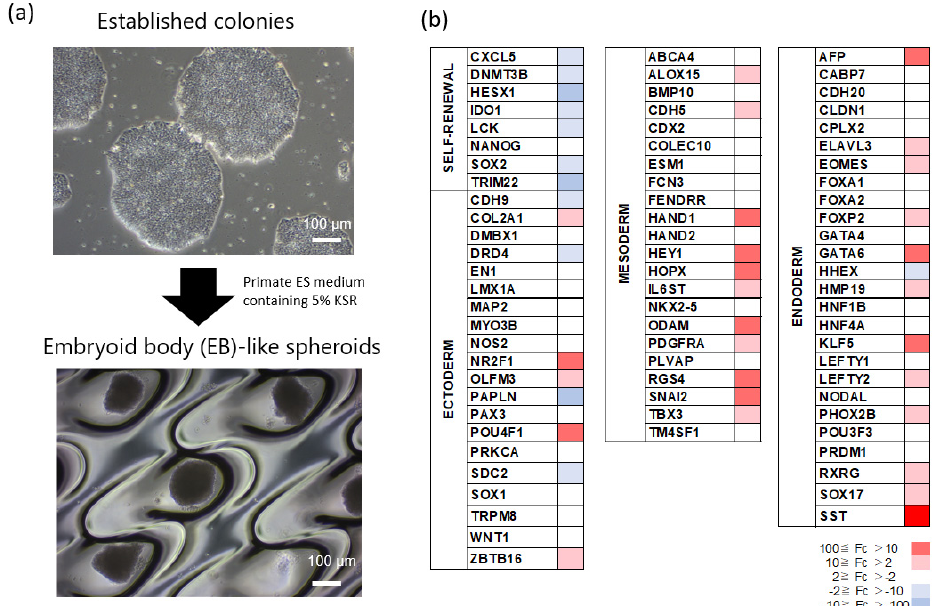
Figure 2. Relative expression of self-renewal and differentiation genes in EB-like spheroids derived from the established colonies. ( a ) EBs induced by the established colonies in the specific culture conditions. White bar = 100 µm. ( b ) Change in gene expression during EB-like spheroid formation with the established colonies. Gene expression of EB-like spheroids formed from the established colonies in 7-day cultures was determined using microarray analysis. Gene expression was reported as the relative fold change between the established colonies and EB-like spheroids. The change from red to light purple indicates fold changes (Fc) from 100 to 10, 10 to 2, 2 to − 2, − 2 to − 10, and − 10 to − 100.